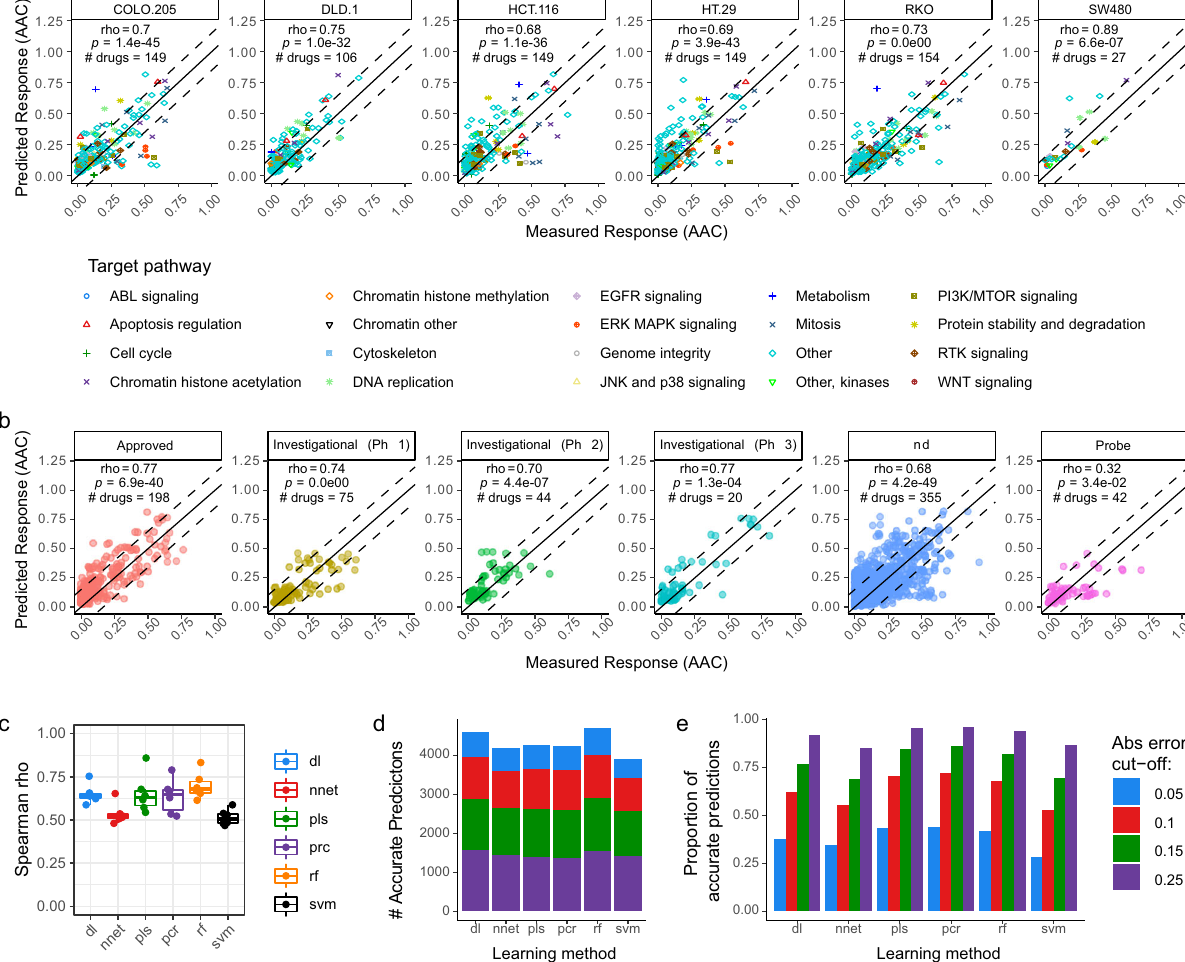
Fig. 5 Accuracy assessment of DRUML to rank drugs based on ef fi cacy using an independent phosphoproteomics dataset. DRUML was used to predict responses to 389 drugs in the colorectal cancer (CRC) cell lines shown using phosphoproteomic data obtained from Piersma et al (Jimenez lab, PRIDE PXD001550) a , b Scatter plots of measured and predicted drug responses. Dotted lines represent 10% absolute error margin, each data-point represents a drug prediction and statistical signi fi cance of drug ranking was assessed by measuring Spearman ’ s rank correlation coef fi cient. a Model performance across cell lines ( n = 8). Drugs are colored by mode of action. b Comparison of measured and predicted drug responses binned by developmental stage of the drug. c Distribution of Spearman rho values by ML model. Boxplots represent median centers, interquartile box boundaries and range upper and lower hinges. d , e Number ( d ) and proportion ( e ) of accurate predictions of drugs for all cell lines within 0.05, 0.1, 0.15 and 0.25 absolute errors. Learning algorithms were random forest (rf), cubist, bayesian estimation of generalized linear models (bglm), partial least squares (pls), principal component regression (pcr), support vector machine (svm), deep learning (dl) and neural network